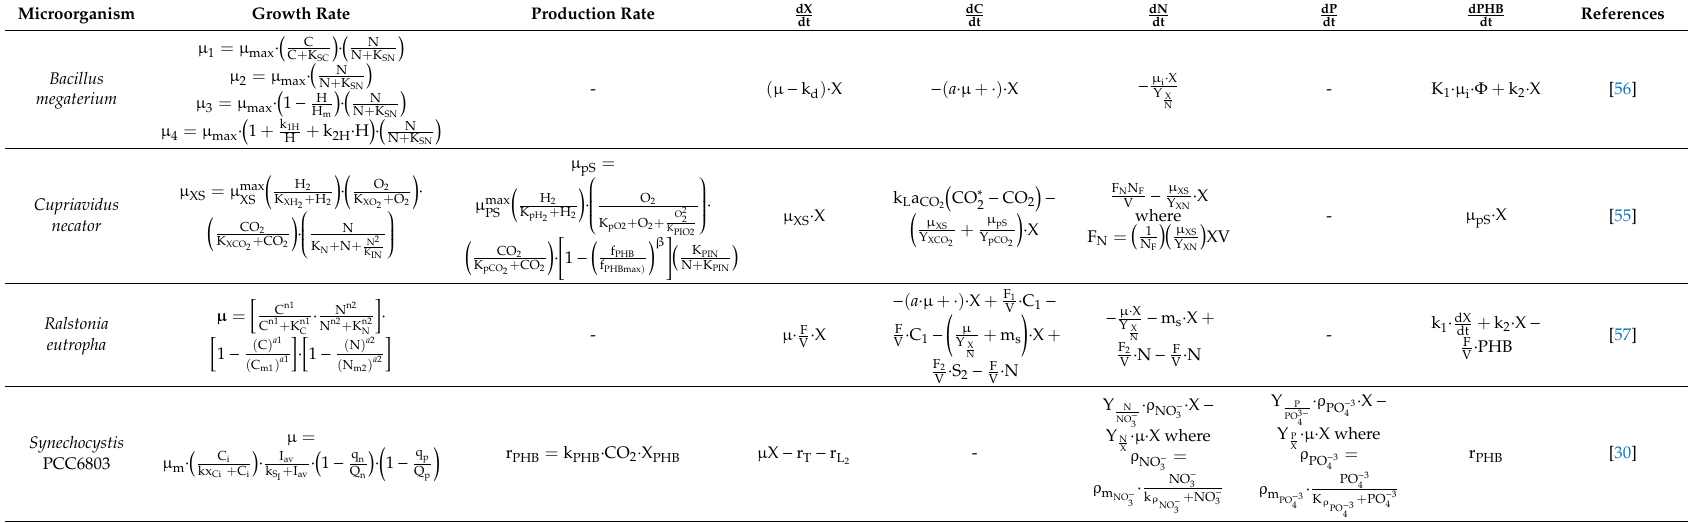
Table 6. Mathematical models for PHB production. Classical Monod, Haldane, Droop, and Pirt sub-models (with associated kinetic and stoichiometric parameters) represent the main blocks of the complete